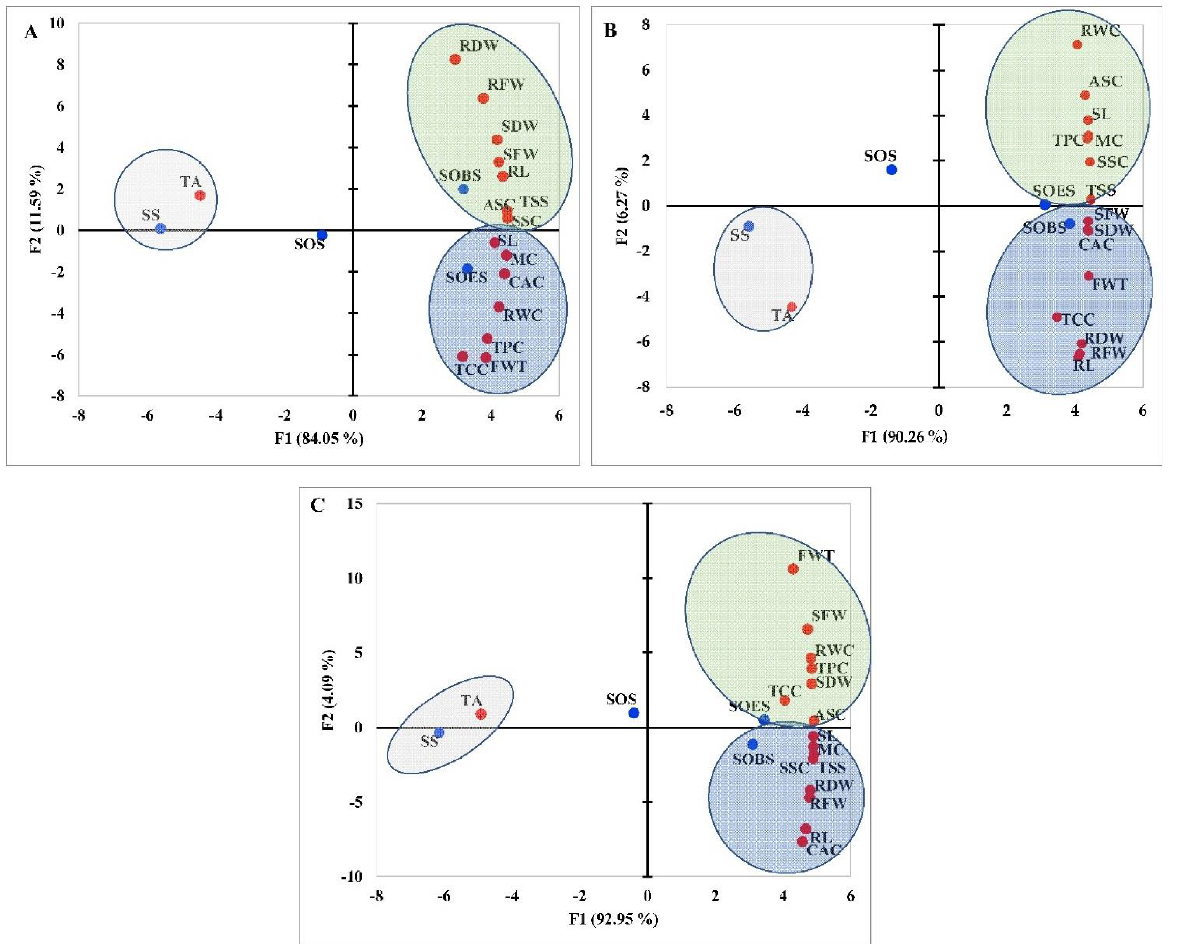
Figure 1. PCA plot showing the distribution of various morpho-physiological and fruit physico- chemical traits and treatments under first ( A ), second ( B ), and both ( C ) stress conditions. SL: shoot length, SFW: shoot fresh weight, SDW: shoot dry weight, RL: root length, RFW: root fresh weight, RDW: root dry weight, FWT: fruits weight per plant, RWC: relative water content, TCC: total